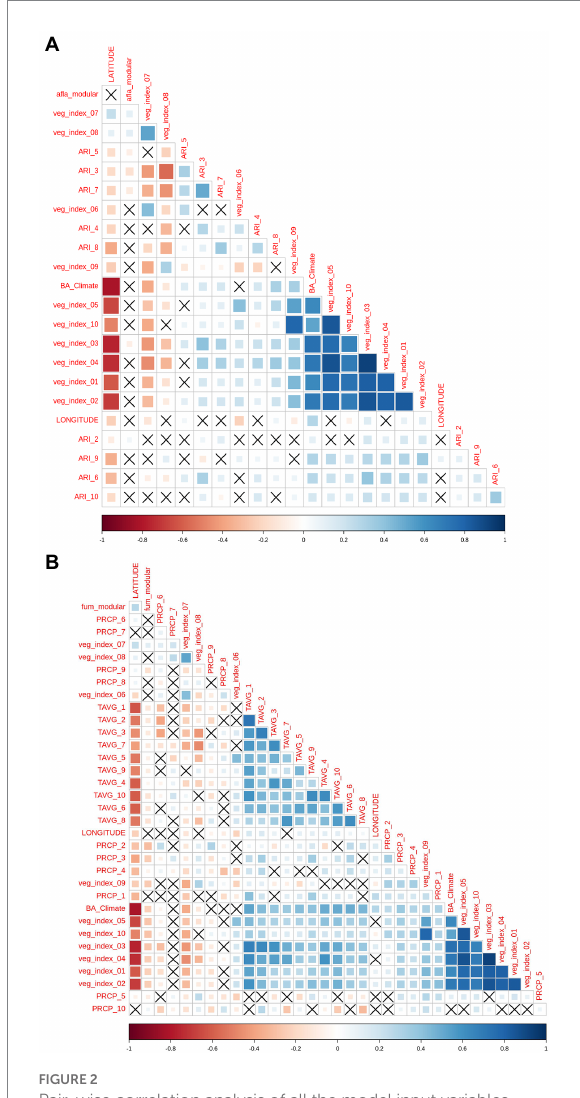
(Figure 3A; Supplementary Table 1). ARI in March was the feature with the highest influence in the model, which was unexpected because at that time of the year there is no corn growing in the field. To account for this, the fungal growth during the first 4 months of the year was weighted to lower values and aflatoxin production index was not included in the ARI calculation function (equations 5 and 6). To summarize, GBM model showed that March, a pre-planting month, had a strong influence over predictions for AFL contamination at harvest time. This observation provided a key to understand the environment-fungi- corn multi-way interactions that can be inferred from the predictions of the GBM model.